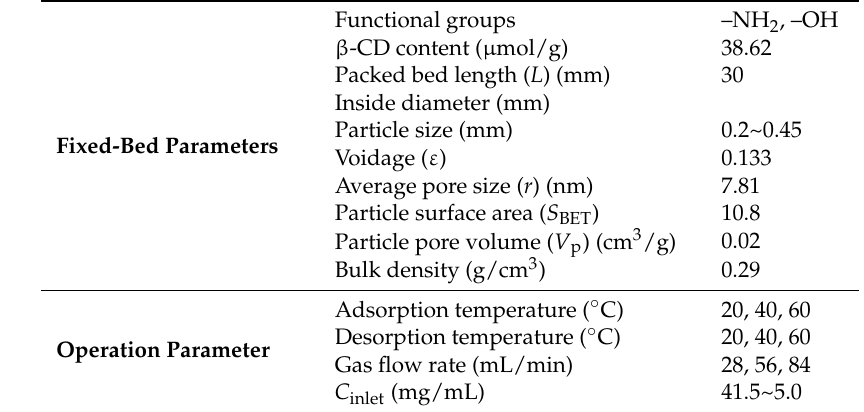
Table 1. Physical properties of chitosan via glutaraldehyde (CGC) and operating conditions for adsorption